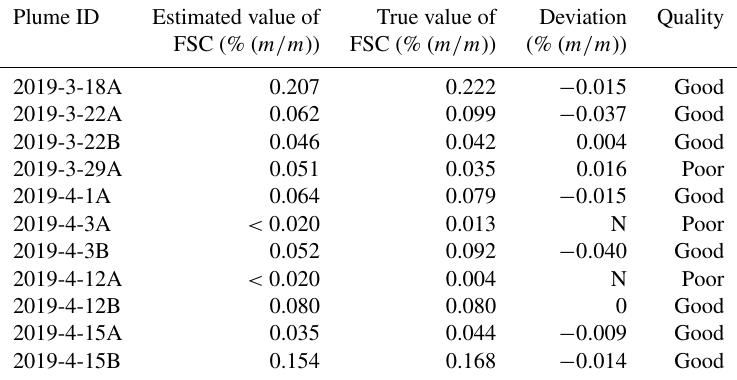
Table 3. Comparison and verification of the estimated (UAV) and true (sampled fuel) values of the FSC from 11 berthing ships. “N” means the deviation has no a specific value, but it is less than 0.020% ( m/m ). Plume